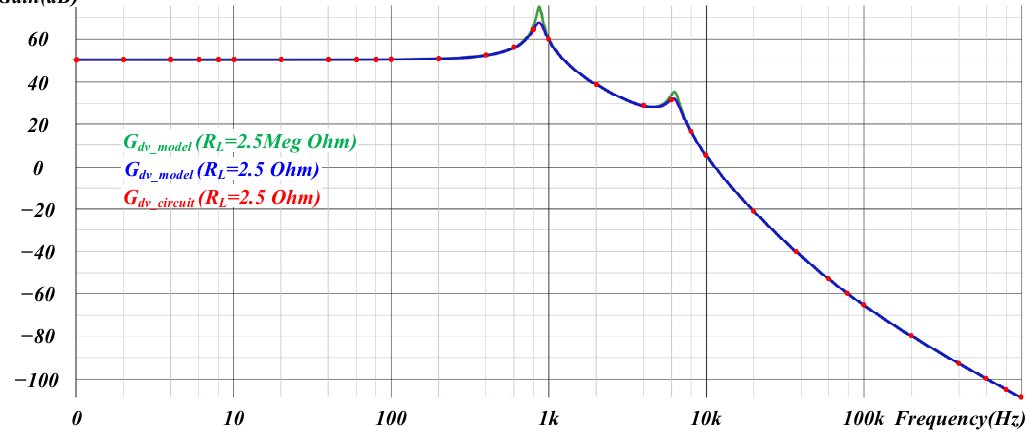
Figure 21. Bode plot of the G dv transfer function of the small-signal model and the actual circuit operation of the cascaded buck converter in the form of coupled inductance.